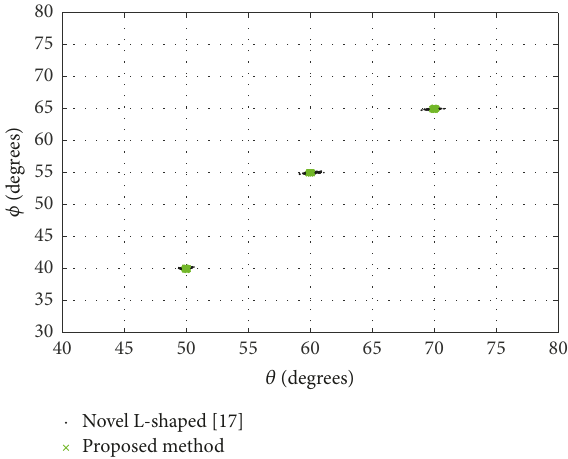
Figure 7: Standard deviation versus SNR for the proposed method in the presence of two coherent sources located at (𝜃 1 = 55 ∘ ,𝜙 1 = 40 ∘ ) and (𝜃 = 70 ∘ , 𝜙 = 50 ∘ ) and a noncoherent source located at 2 2 (𝜃 = 80 ∘ ,𝜙 = 60 ∘ ) . 3 3